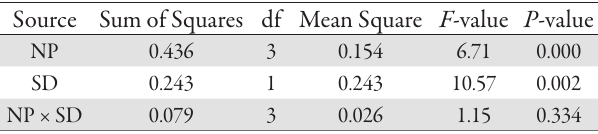
Tab. 1. Analysis of variance (ANOVA) for the effect of number of machine